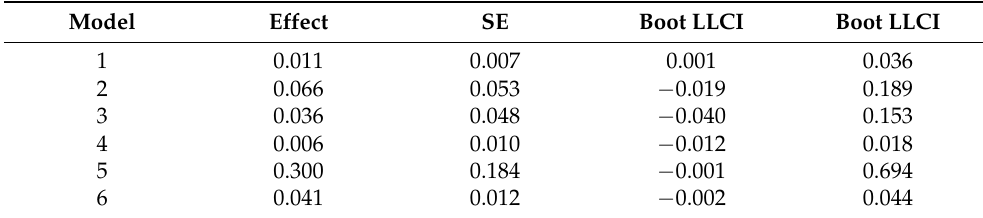
Table 3. The mediation indices for the tested